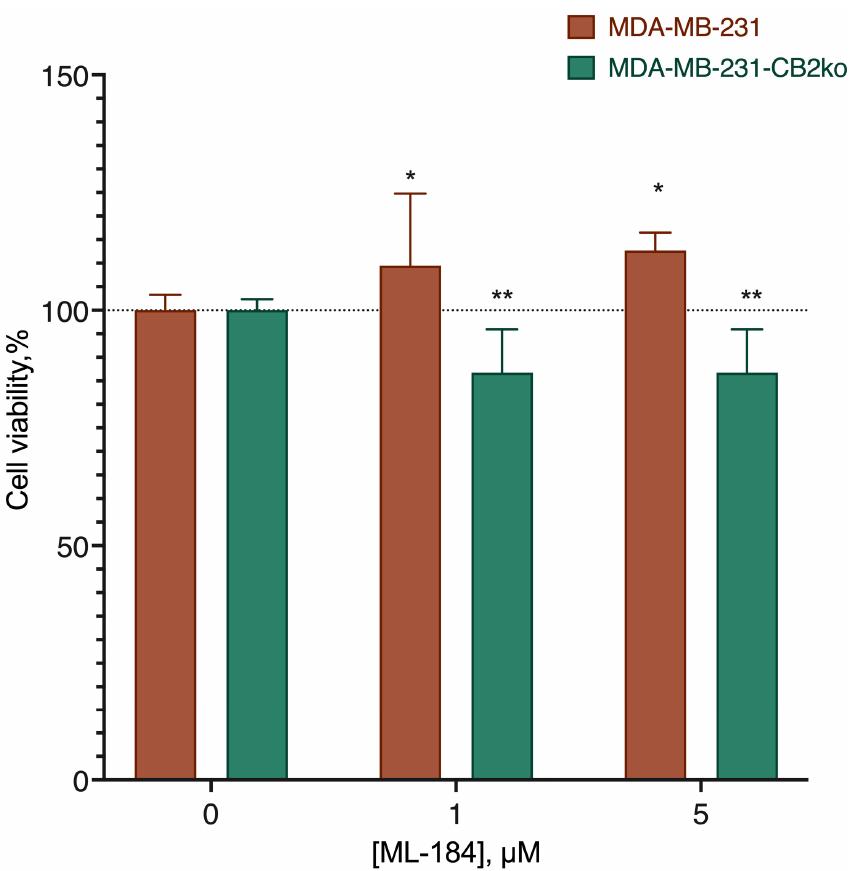
Figure 5. Comparison of the GPR55 agonist ML-184 activity on the original cell line and the line knocked out at the CB2 receptor. *, a statistically significant difference from the control without the substance; **, a statistically significant difference from the same concentration on the native cell line in the ANOVA test with the Holm–Sidak post ‐ test. The observed stimulation of proliferation and its disappearance in the CB2 knockouts could be interpreted in several ways: a direct interaction of the ligand with the CB2 recep ‐ tor without the participation of GPR55; a signal transmission in the GPR55 ‐ CB2 complex;